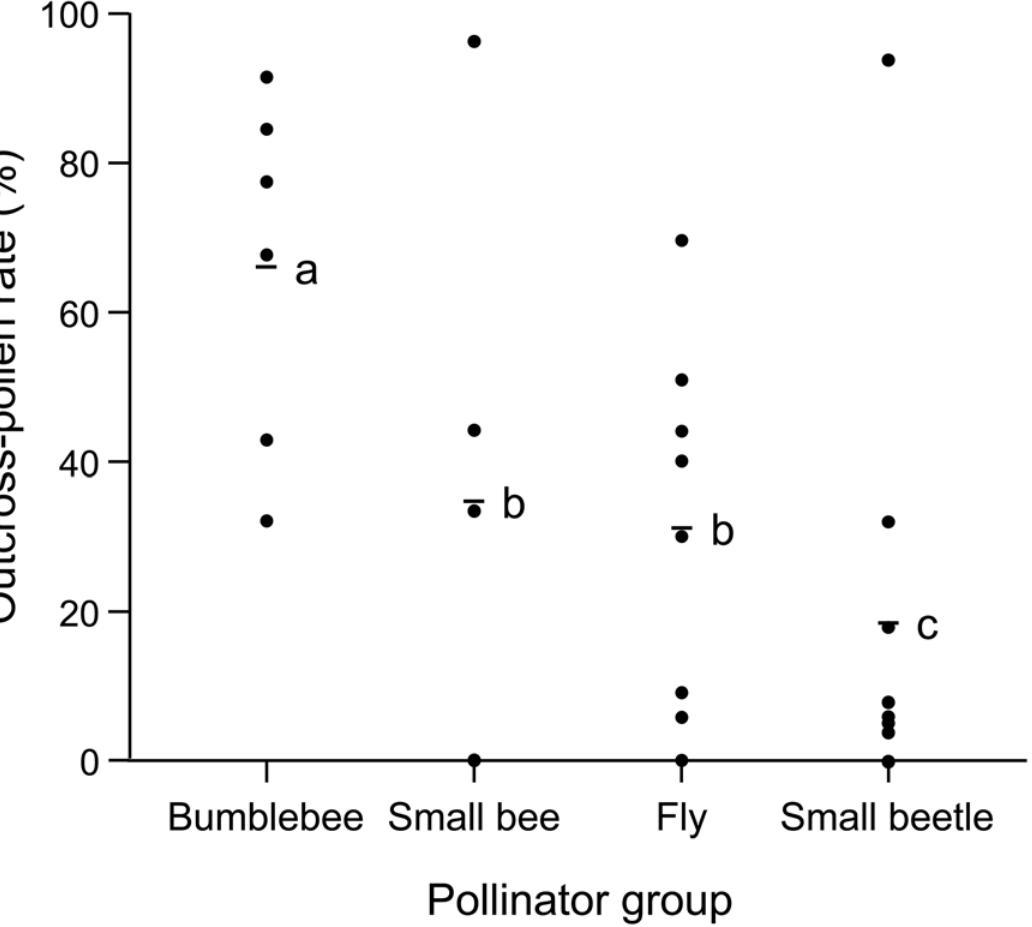
Fig 2. Proportion of outcross-pollen grains found on insects visiting Castanea crenata . Circles and bars represent each individual insect samples and the average value for each insect group, respectively. Values with different letters are significantly different at P < 0.008 (GLMM with Bonferroni adjustment). Bumblebee, n = 6; small bee, n = 5; fly, n = 8; small beetle, n =